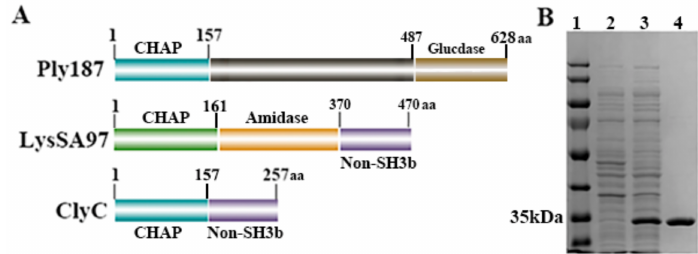
Figure 1. Construction of chimeric lysin ClyC. ( A ) Schematic representation of ClyC. ( B ) SDS-PAGE analysis of ClyC. Lane 1: Standard protein marker. Lane 2: Total bacterial solution before induction. Lane 3: Total bacterial solution after induction. Lane 4: Purified protein.